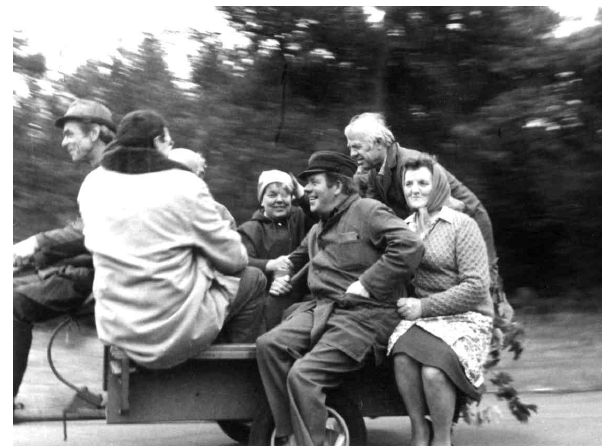
Figure 24. One of the observers (right) and the author (hanging) mounting the feeders for the ionosonde antenna (1965).